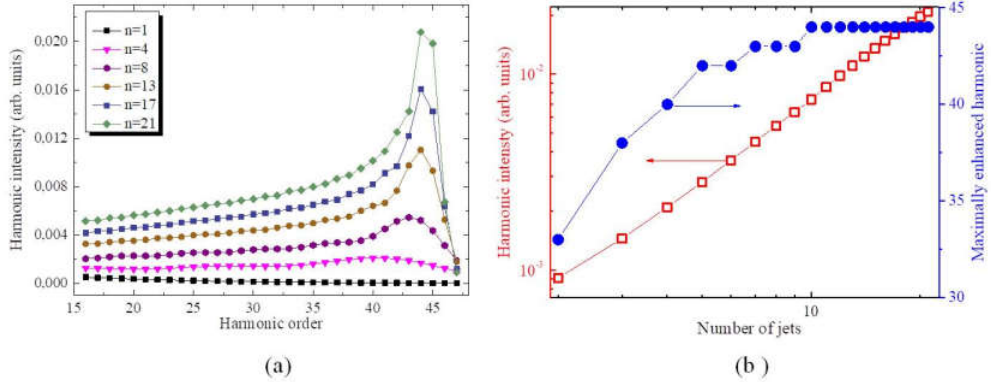
Figure 6. ( a ) Harmonic distribution in the case of silver MJP during propagation of two-color pulses (1310 nm + 655 nm) through the plasmas consisting of different number of jets. Single jet sizes were 0.23 mm. ( b ) H qpm and its intensity as the functions of n (blue filled circles and black empty squares).